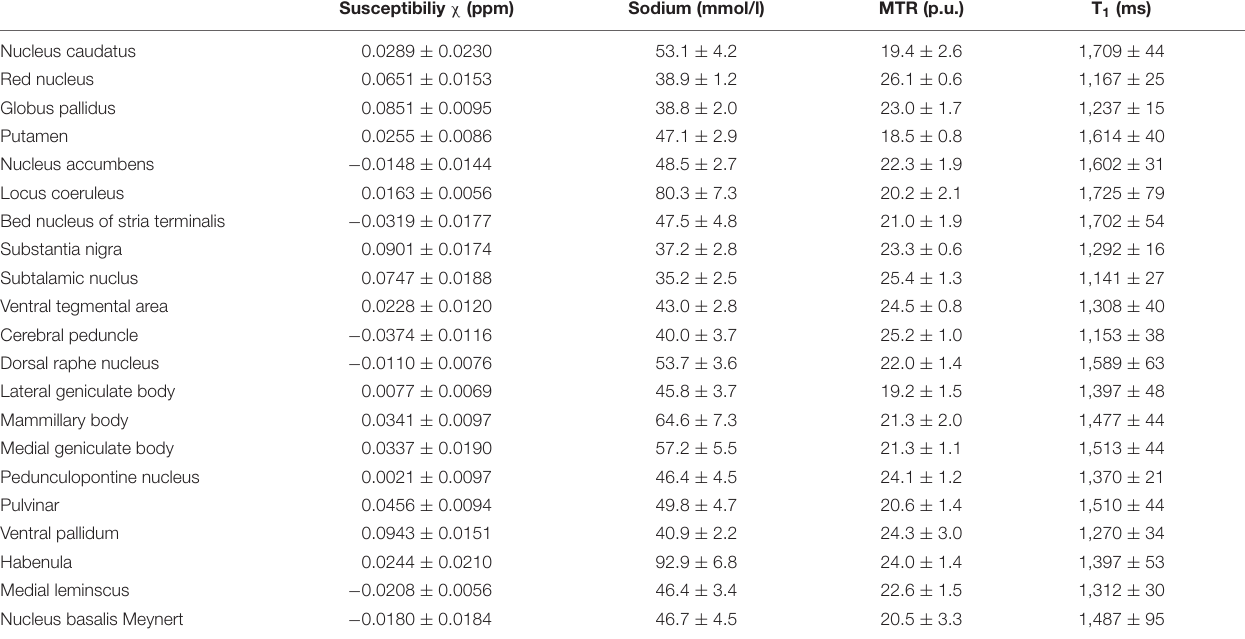
TABLE 4 | Mean susceptibility, sodium concentration, MTR and T 1 values are given with standard deviation for each nucleus. Susceptibiliy χ